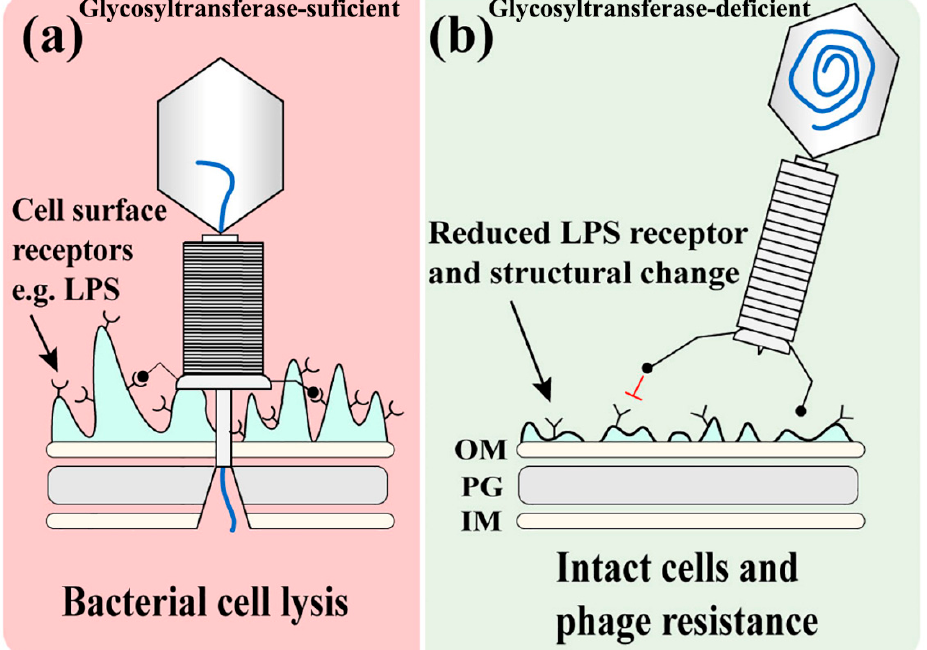
Figure 9. Mechanistic model for glycosyltransferase-mediated initial interaction between bacteria and phages. ( a ) After the phage binds to the host cell surface receptors including LPS, phage contracts and injects phage DNA into bacterial cytoplasm, leading to bacterial cell lysis. ( b ) The mutation of the glycosyltransferase gene reduces LPS receptors and alters bacterial surface structures, leading to the reduced adsorption of phages and the resistance to phages. Red T sign means the Barrier of phage adsorption to bacterial surface.